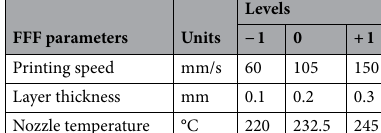
Table 2. FFF process parameters and